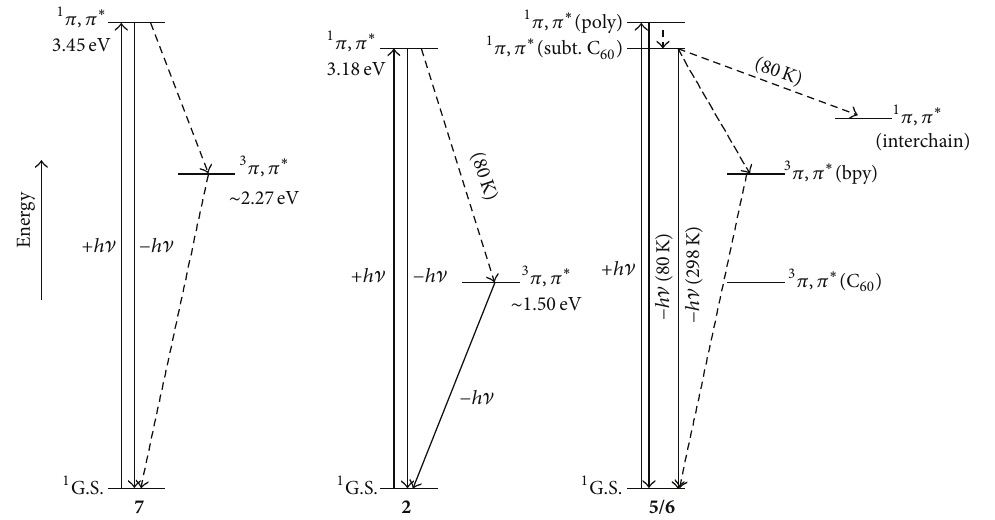
Scheme 5: Jablonski diagram of monomer 2 and polymers 5 – 7